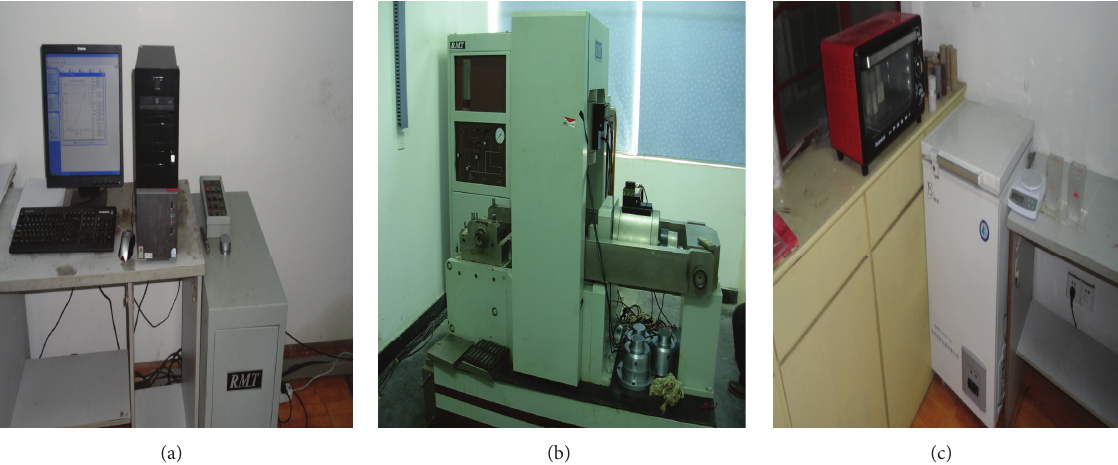
Figure 3: Test equipment: (a) data logger of RMT-150B multifunction automatic rigid rock servo material testing machine, (b) loading system of RMT-150B multifunction automatic rigid rock servo material testing machine, and (c) oven, which is used to test sample, make its curing as soon as possible, and increase its